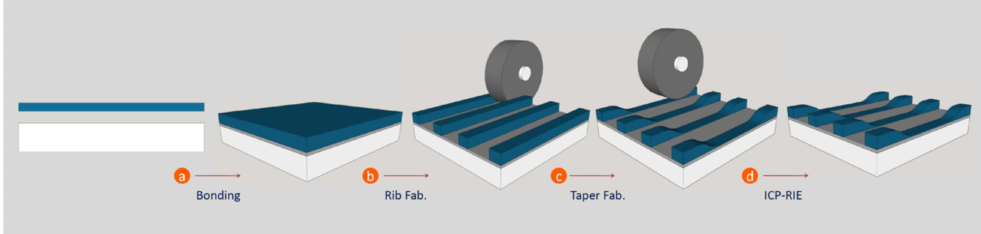
Figure 2. Taper waveguide fabrication scheme. ( a ) KLuW / NOA83H / SiO 2 bonding step (NOA stands for Norland Optical Adhesive). ( b ) Rib waveguide fabrication. ( c ) Taper waveguide cut. ( d ) Inductively coupled plasma reactive ion etching (ICP-RIE)